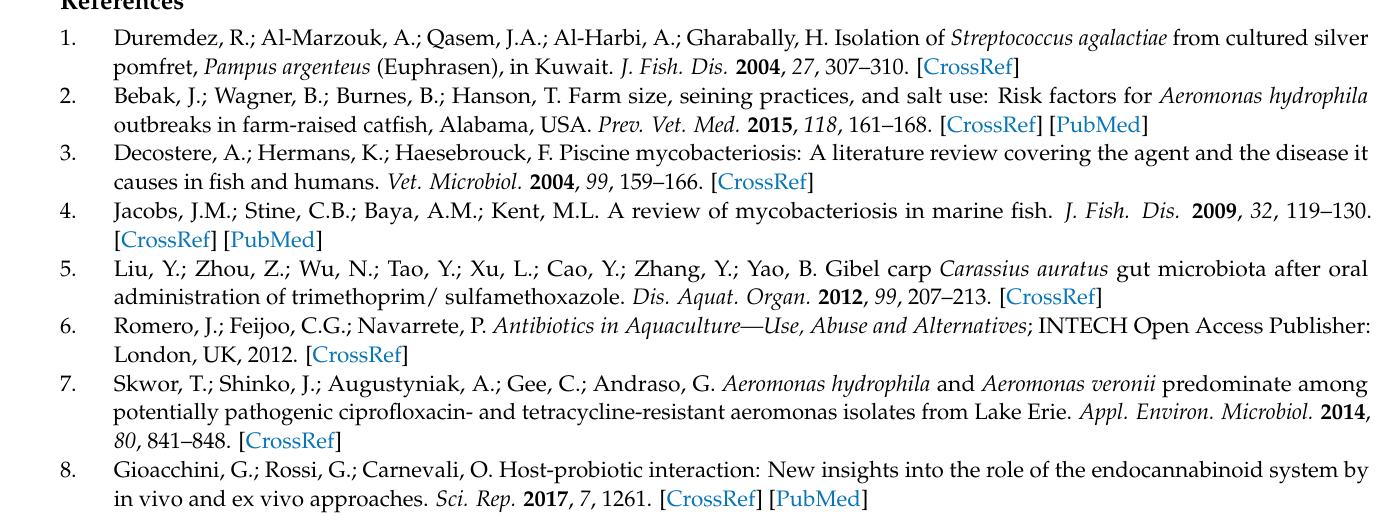
Figure S4. Relative abundance of the top 5